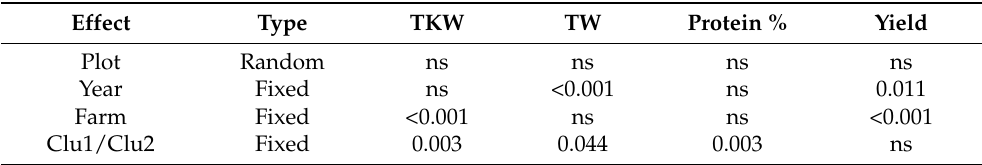
Table 2. Significant p -values from ANOVA F-tests, for each trait analyzed from in situ experiment samples conducted in 2019 and